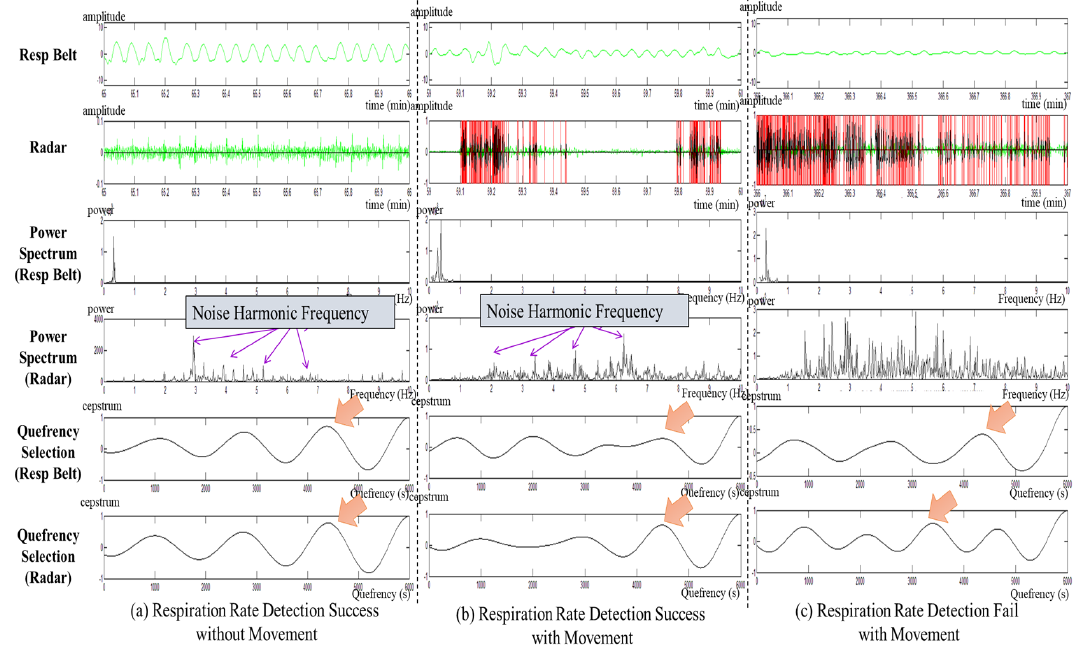
Figure 4. Visual inspection results with movement noise: ( a ) respiration rate detection success without movement, ( b ) respiration rate detection success with movement, and ( c ) respiration rate detection failure with movement.